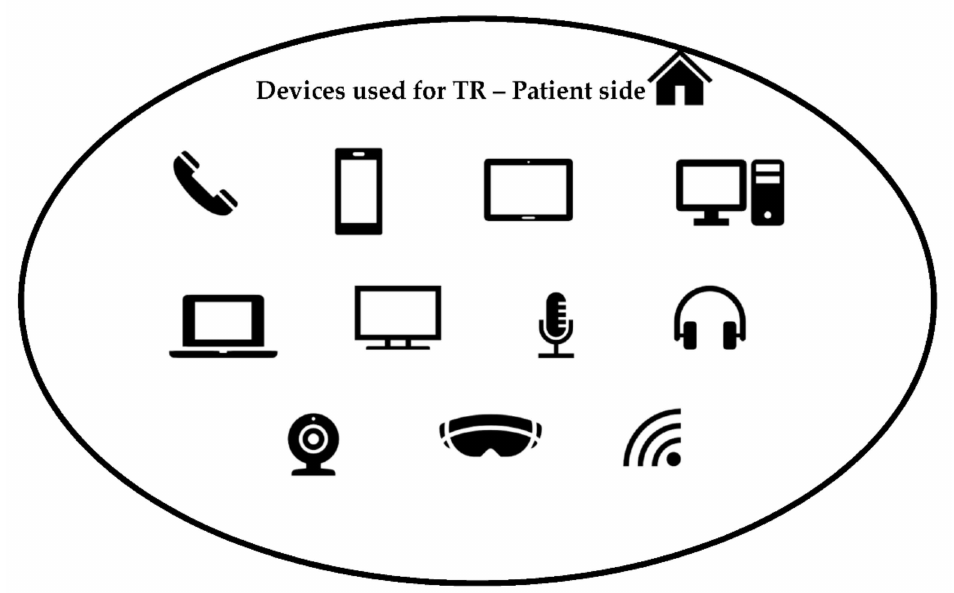
Figure 2. Devices used for TR at the patient’s home.